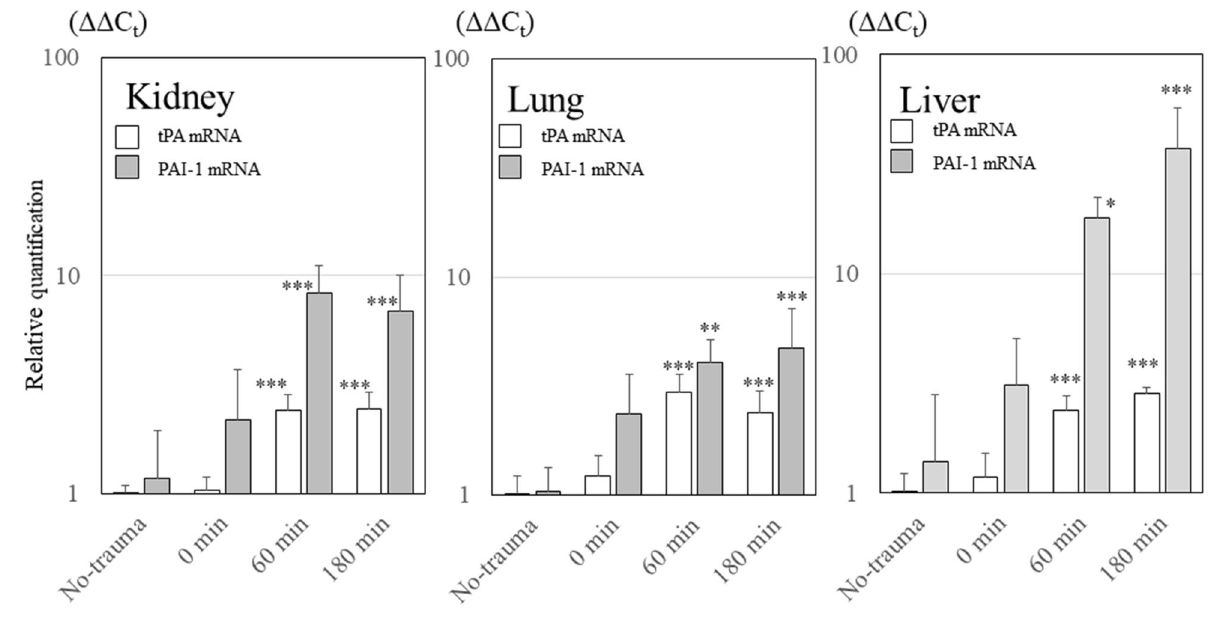
Figure 4. Changes in tPA and PAI-1 mRNA expression levels in various organs. The mRNA expression levels of both tPA and PAI-1 gradually increased after trauma in all organs (all comparisons revealed P < 0.001, one-way ANOVA). The increase in PAI-1 mRNA expression was higher than that of tPA mRNA (in kidney, P < 0.001; in liver, P < 0.001; in lung, P = 0062; two-way ANOVA). tPA, tissue-plasminogen activator; PAI-1, plasminogen activator inhibitor-1. *** P < 0.001 using Dunnett’s test for the no-trauma group; ** P < 0.01 using Dunnett’s test for the no-trauma group; * P < 0.05 using Dunnett’s test for the no-trauma